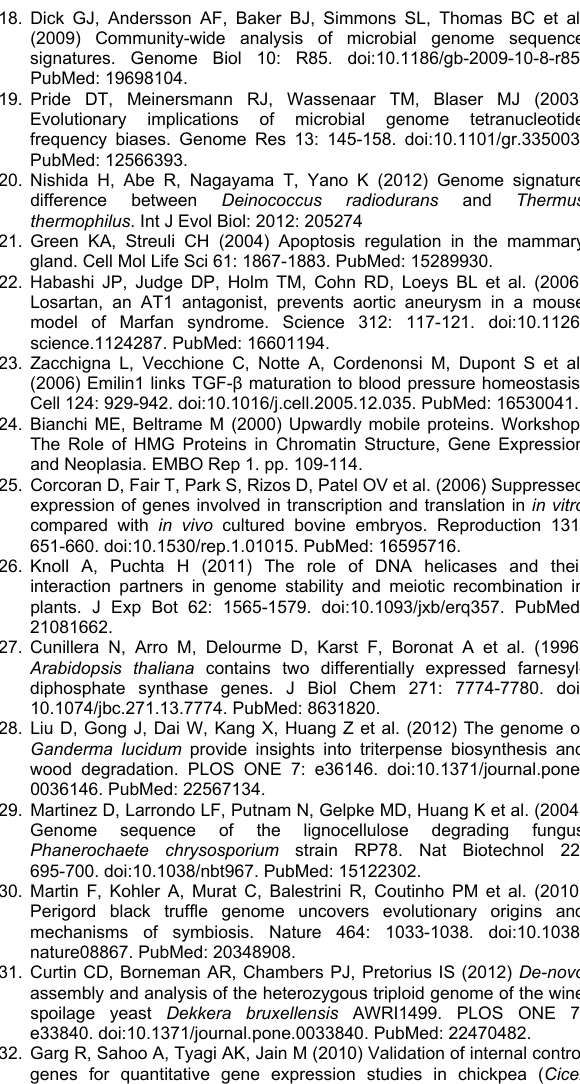
Table S3. The numbers of reads mapped to each